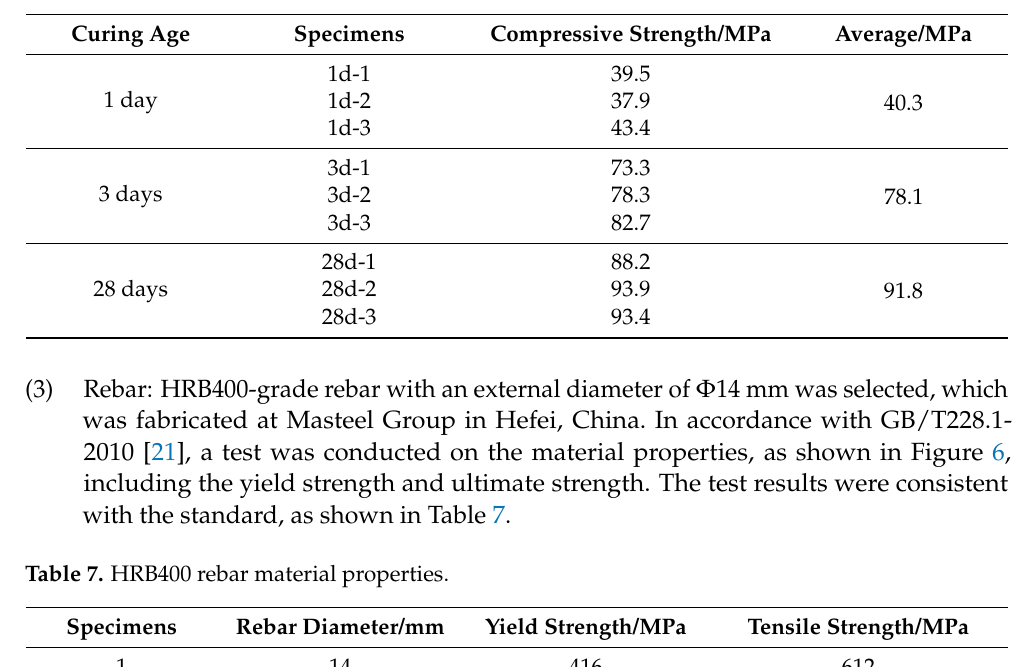
Table 6. Results of grouting material compressive strength test.